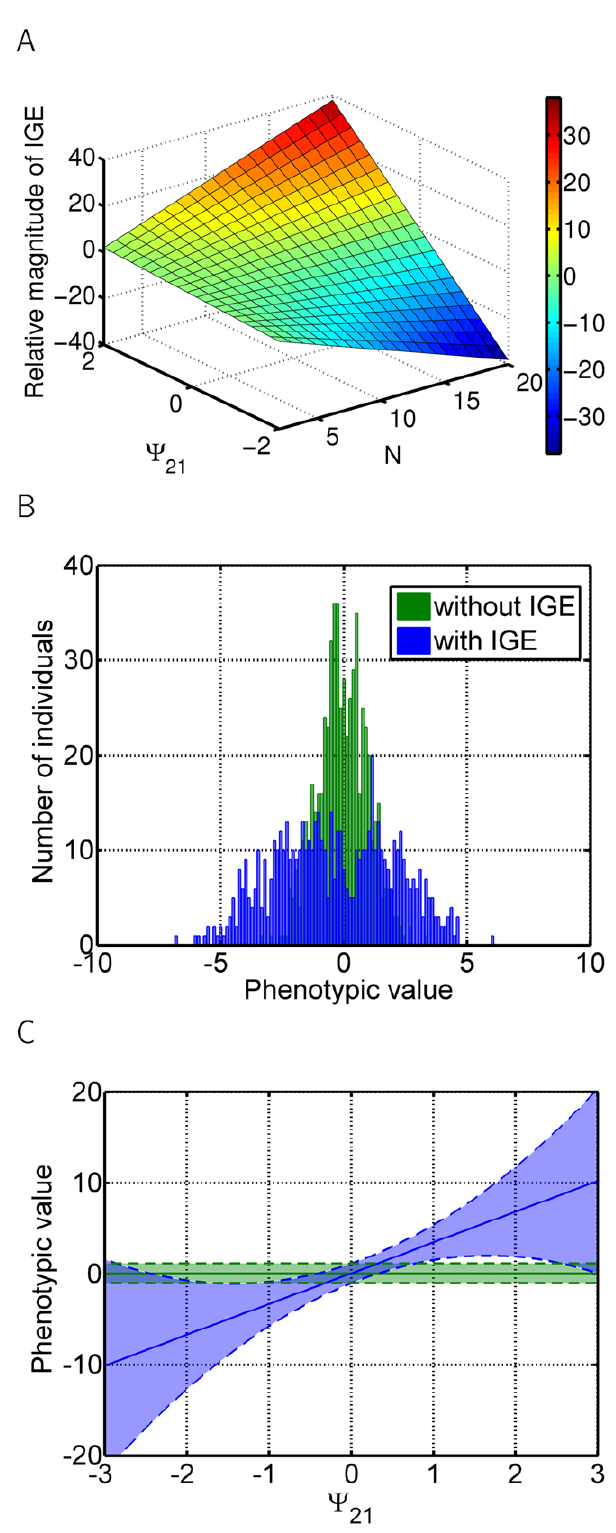
Figure 2. Interactions without feedback. Indirect genetic effects of gene x on trait Y (see Figure 1 A), with trait X affecting trait Y. (A) Relative magnitude of indirect genetic effect, as described in equation 6, with the strength of the interaction Y 21 ~ 0 : 5 . (B) Histogram of the phenotypic values across population. Green - without IGEs, blue - with IGEs. Strength of the interaction set to Y 21 ~ 0 : 5 . (C) Mean